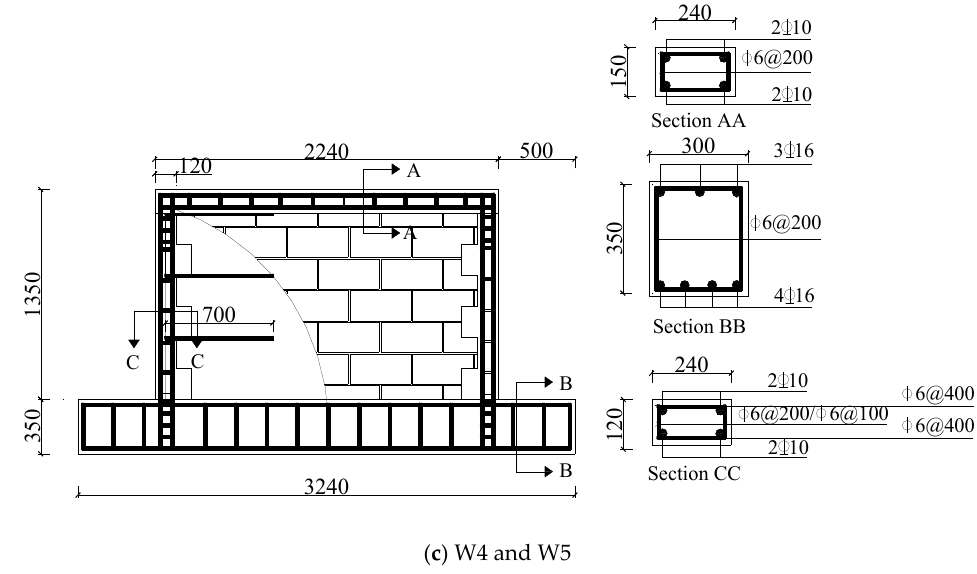
Figure 5. Size of the specimens: ( a ) W1 and W2; ( b ) W3; ( c ) W4 and W5.